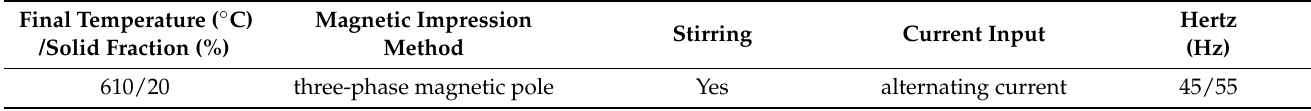
Table 3. Experiment conditions for manufacturing a two-cavity lower arm in EMS